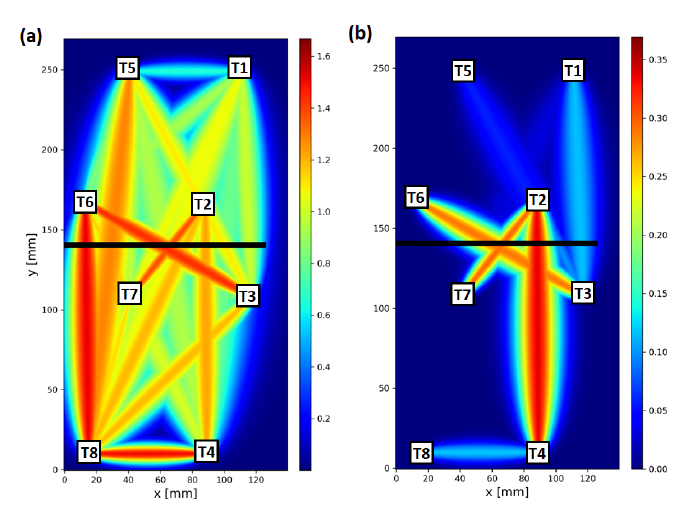
Figure 12. Visualization of corr damage index for specimen no. 1 above 60 ◦ C with an indication of introduced damage and sensors localization: ( a ) uncompensated damage index; ( b ) standard compensation scheme with k = 3.